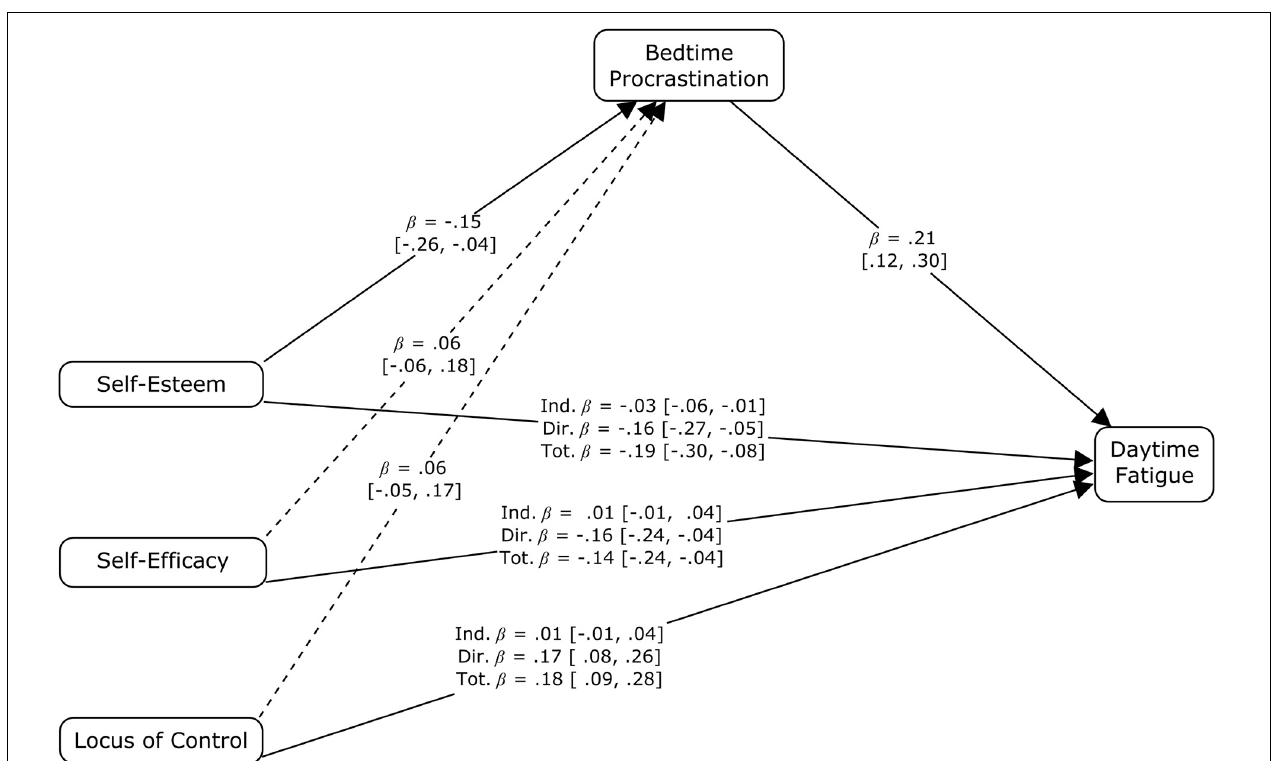
FIGURE 4 | Standardized parameter estimates for indirect, direct and total effects of self-esteem, general self-efficacy and locus of control on self-reported average frequency of daytime fatigue with bedtime procrastination as a mediating variable. β – standardized estimate with the limits of bootstrapped 95% confidence intervals [given in brackets]; solid arrows – significant components of indirect effects or significant direct effects; dotted arrows – insignificant components of indirect